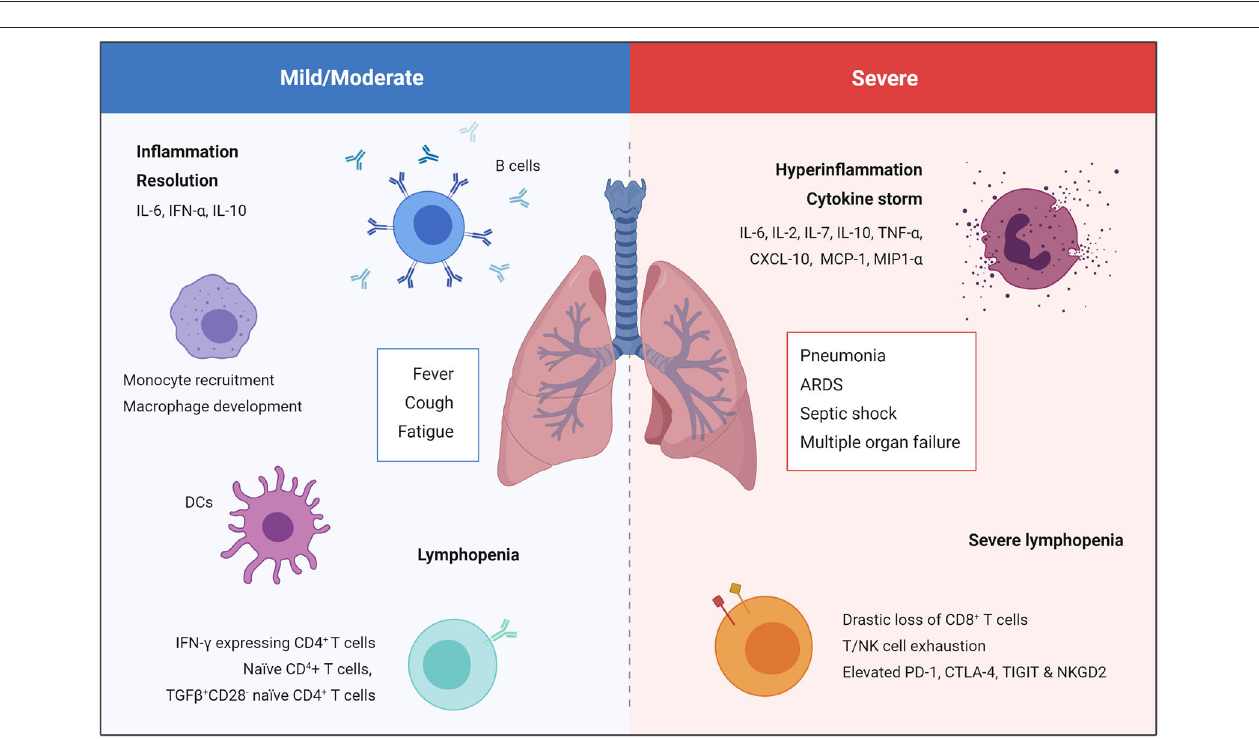
FIGURE 2 | Immune response in mild/moderate and severe COVID-19 cases. Mild/moderate COVID-19 is characterized by local inflammation, the recruitment of monocytes, DCs, NK cells, T and B cells, followed by resolution of the infection and inflammation. Severe COVID-19 is characterized by severe lymphopenia, T cell exhaustion, and systemic hyperinflammation that can cause the development of critical and potentially life-threatening complication such as severe pneumonia, ARDS, septic shock, and multiple organ failure (17, 30, 33).